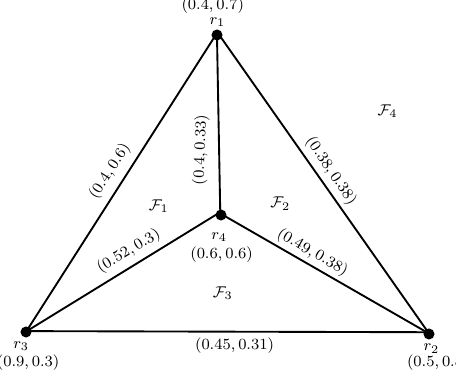
Figure 5.1: Faces in Pythagorean fuzzy planar graph Figure 10. Faces in Pythagorean fuzzy planar